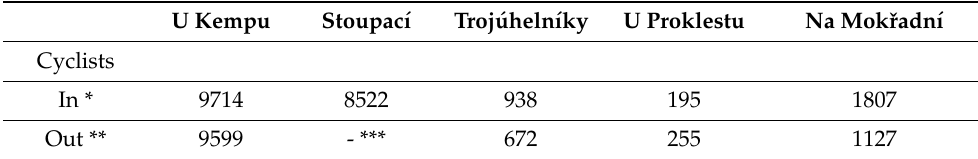
Table 2. Number of cyclists according to each